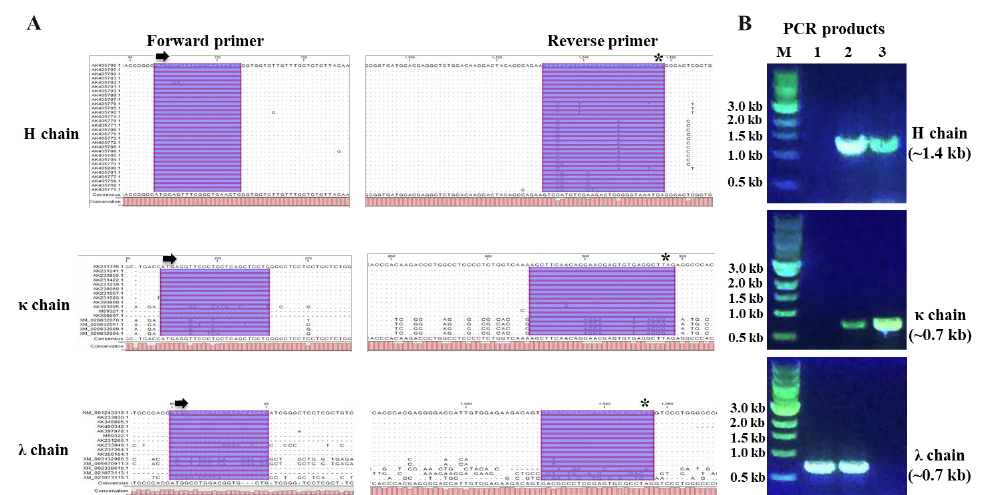
Figure 2. Primer design and single-cell RT-PCR to amplify whole coding regions of porcine IgG chains. ( A ) The 5′ end and 3′ end alignment of porcine IgG heave and light chain genes. Arrow indicates the translation initiation codon. Asterisk indicates the translation stop codon. ( B ) Representative 1% gel electrophoresis patterns of the PCR products. M, marker; 1-3, PCR products from different single B cells.